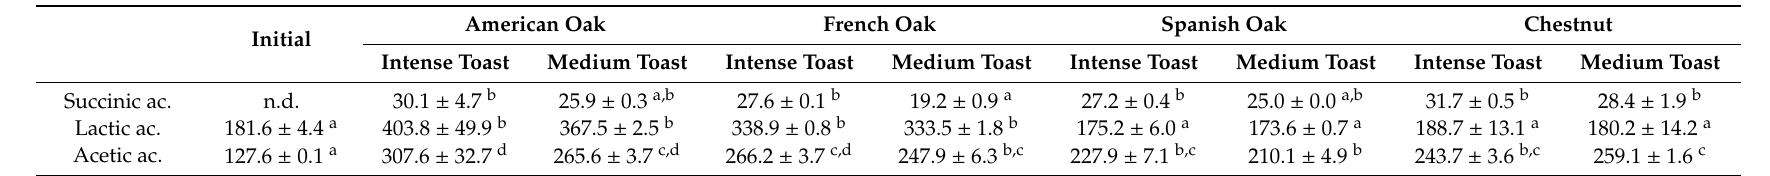
Table 4. Organic acid contents (mg / L) of distillates ageing in barrel of American, French and Spanish oak, and Chestnut.